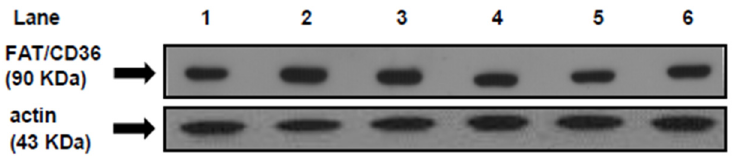
Table 6. Intramyocardial lipid accumulation and PDHc activity of rats fed a control diet (CD),